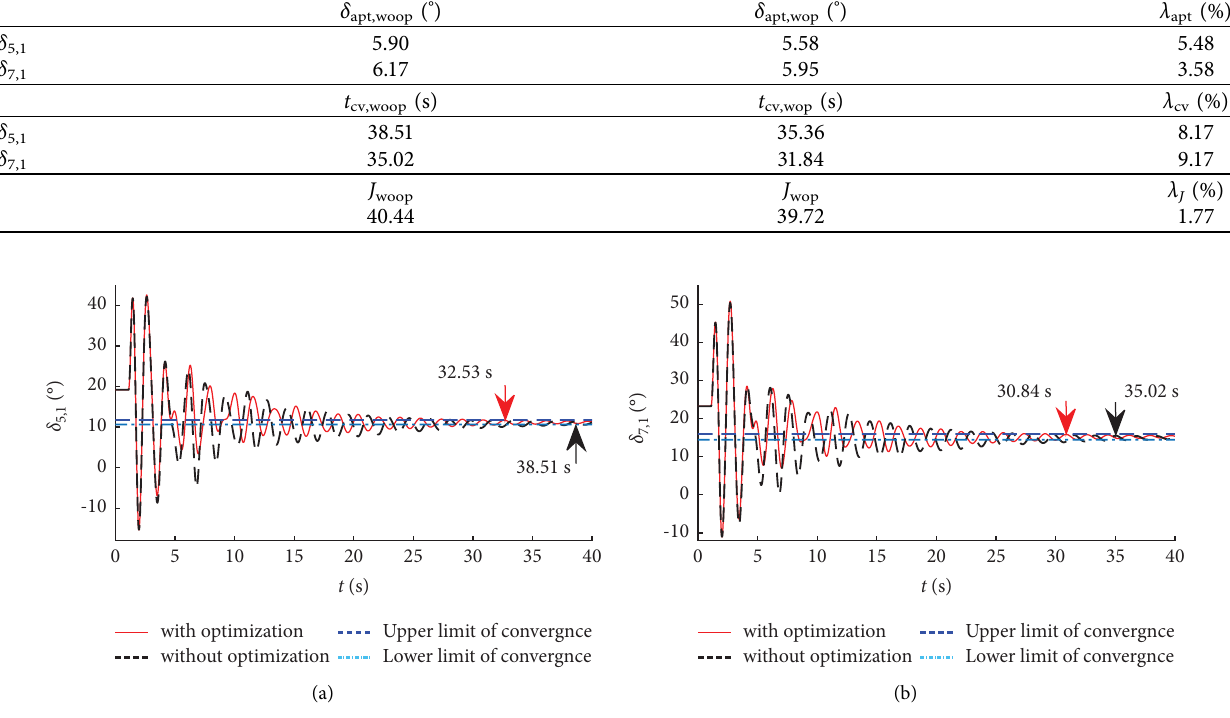
Figure 12: Power angle diference between SGs with and without optimization to K A , K F , T F , and V ref . (a) Power angle diference between #5 and #1 SGs. (b) Te power angle diference between #7 and #1 SGs. Table 9: Efect analysis of optimization for K A , K F , T F , and V ref